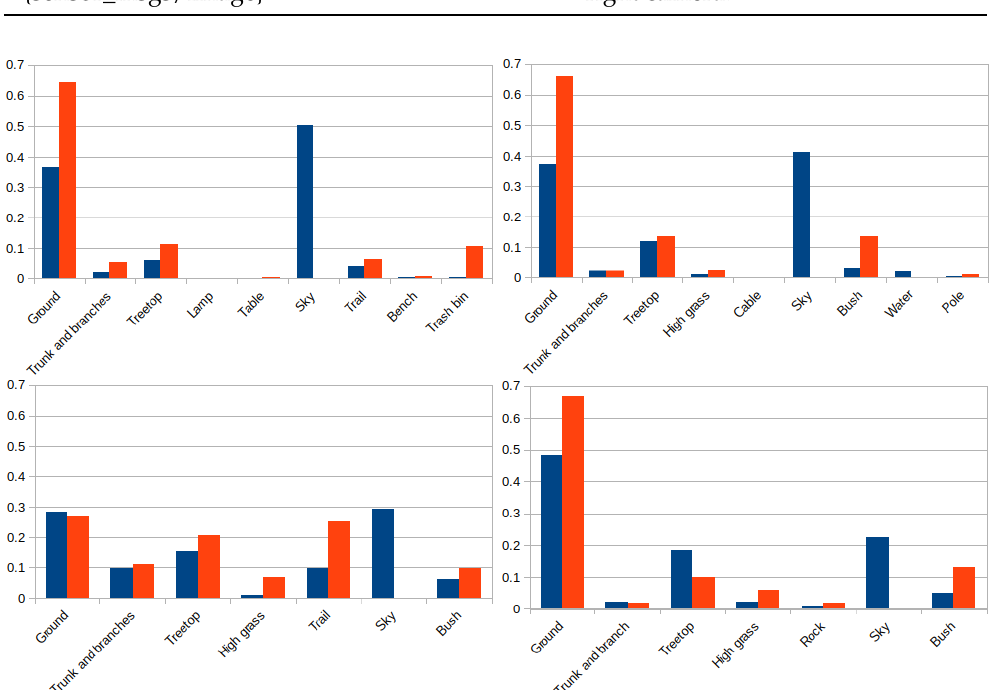
Figure 21. Label distribution for pixels (blue) and 3D points (red) in the park ( up-right ), lake ( up-left ), forest ( down-right ) and hill ( down-left )